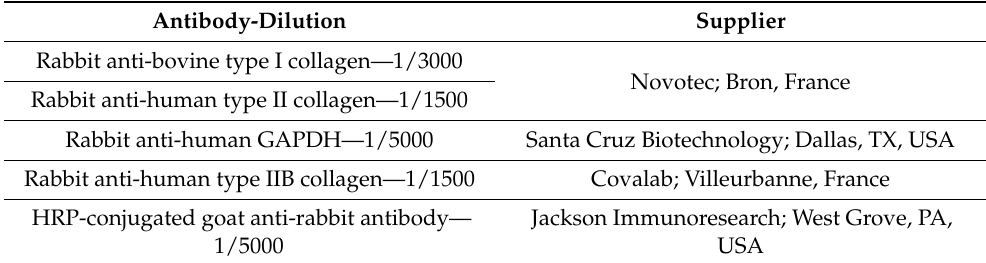
Table 2. Antibodies used for Western